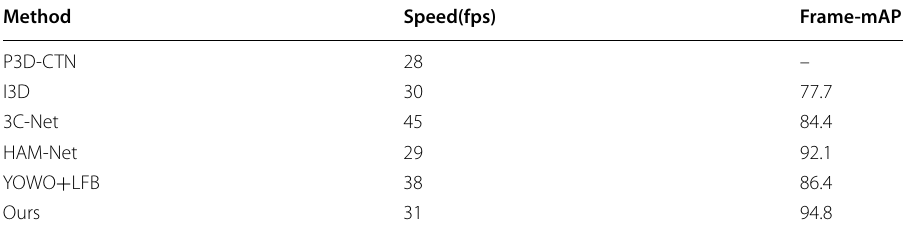
Table 4 It is about the run time and performance comparison on data set UCF101-24 on a single NVIDIA RTX8000 card with 16-frames video